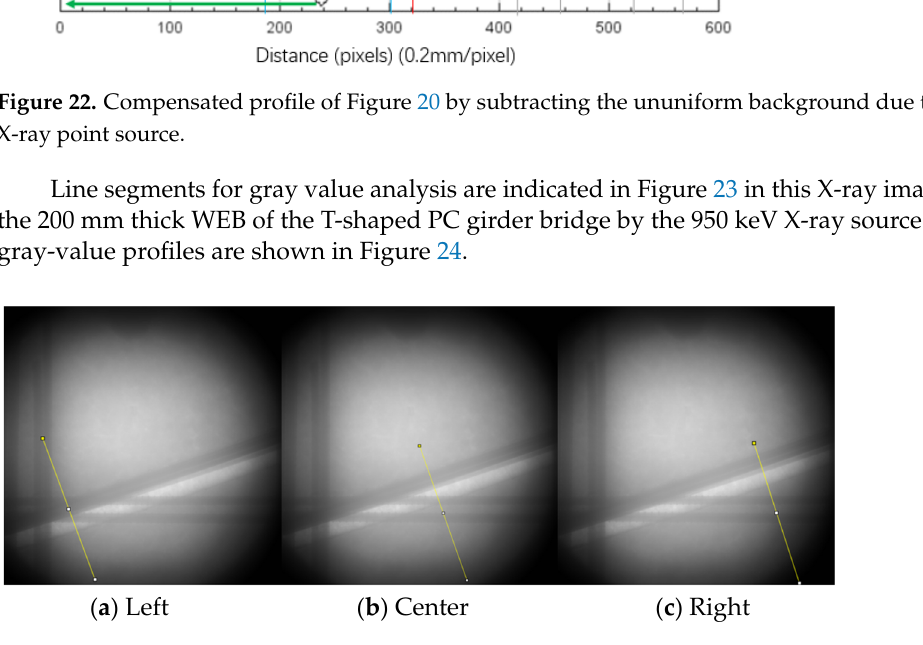
Figure 23. Line segments for gray value analysis for unfilled grout in the X-ray image of 200 mm thick WEB of the T-shape PC girder bridge by the 950 keV X-ray source.